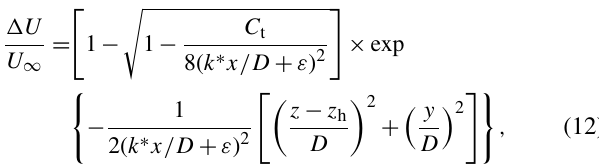
Figure 3. Linear regression of the thrust coefficient obtained from the optimal tuning of the wake models, C t (a–c) , or SCADA data, C t (d–f) : (a) and (d) Jensen model; (b) and (e) Bastankhah model; (c) and directly from the lidar data, C t lidar SCA (f) Larsen model. The solid red line is the linear fitting result, and the dashed blue line is the 1 : 1